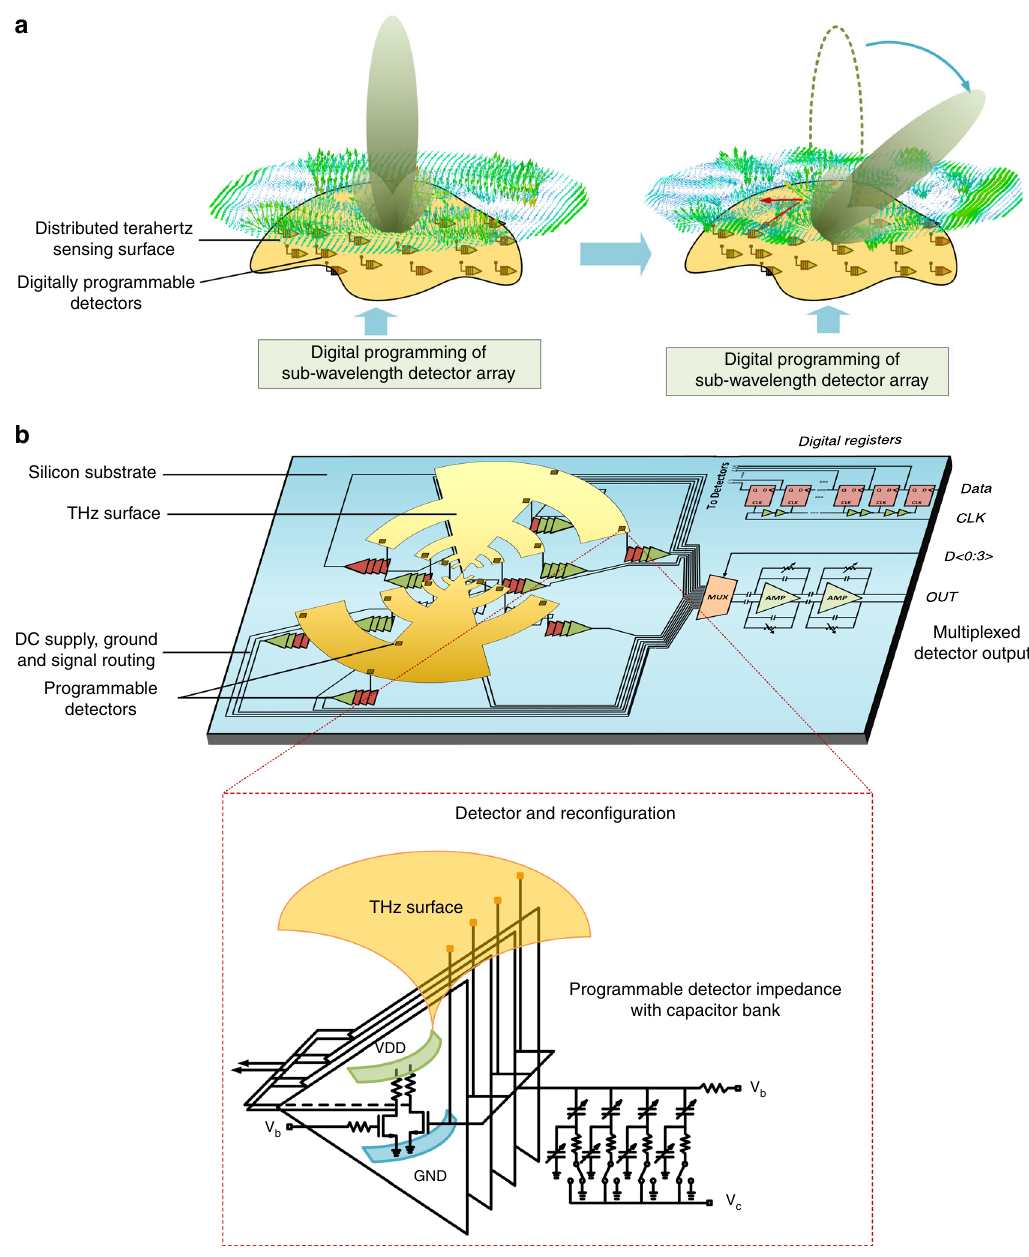
Fig. 1 Programmable terahertz chip-scale interface. a Concept of an universal terahertz sensing surface that maps a large discerte digital recon fi guration space to incident fi eld properties including spectrum, angle of incidence and polarization. This is acheived by directly programming the surface currents induced on the interface at subwavelength scales. The incident power is absorbed in a distributed fashion at the sites of recon fi guration. b The system overview of the implemented terahertz sensor with a log-periodic tooth interface with 16 detectors distributed over the surface. Each site is recon fi gurable with a coded capacitor bank that locally changes the boundary condition to redistribute the surface current distribution. This collectively programs the sensor response to allow for optimal reception against incident spectrum, polarization and angle of